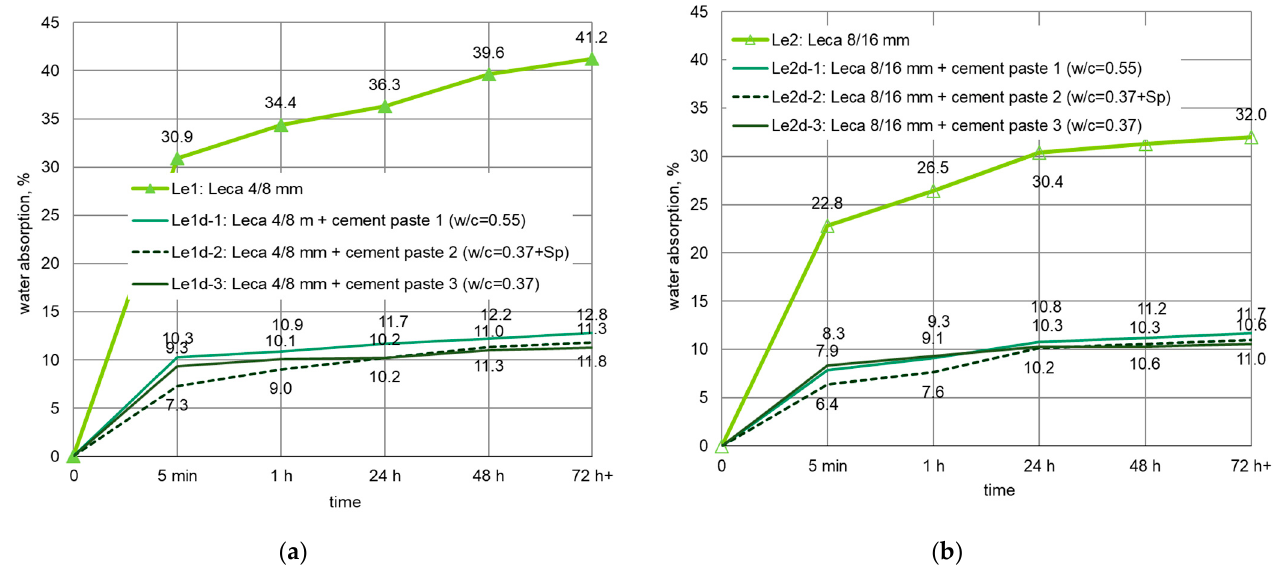
Figure 9. Development of water absorption in time for Leca aggregates impregnated with cement pastes: ( a ) Leca 4/8 mm, ( b ) Leca 8/16 mm.